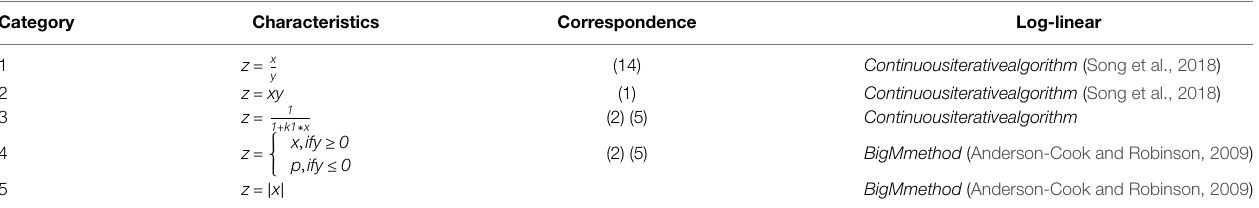
TABLE 2 | Classification of non-convex terms for the